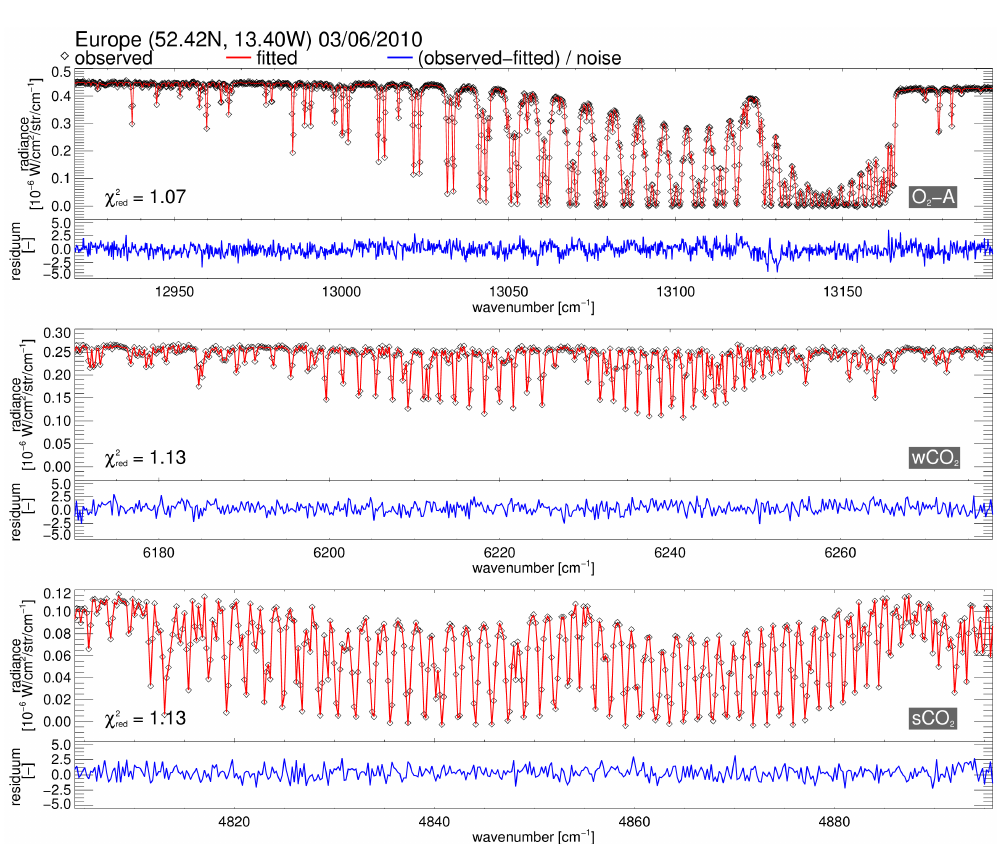
Figure 1. Observed (black) and fitted (red) intensity (radiance) and its residuum (blue) over a typical scene in Germany, near Berlin (52.42 ◦ N, 13.40 ◦ E) on 3 June 2010. Top panel: observed and fitted radiance and the residuum for GOSAT band 1 (12920–13195cm − 1 ). Middle panel: as top panel but for band 2 (6170–6278cm − 1 ). Bottom panel: as top panel but for band 3 (4804–4896cm − 1